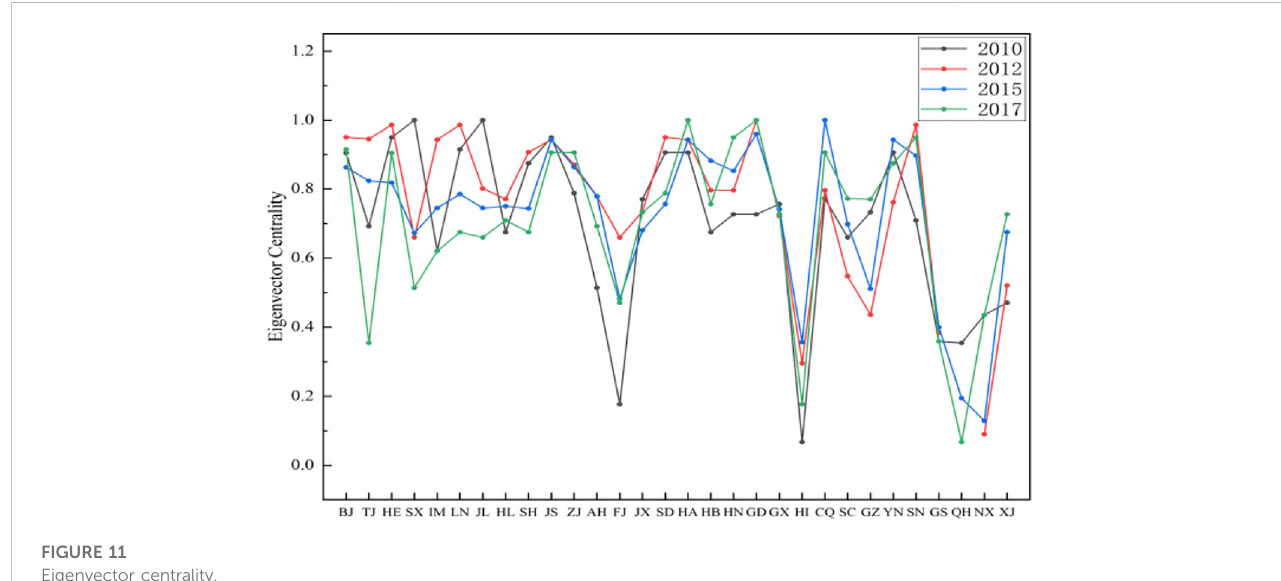
FIGURE 11 Eigenvector